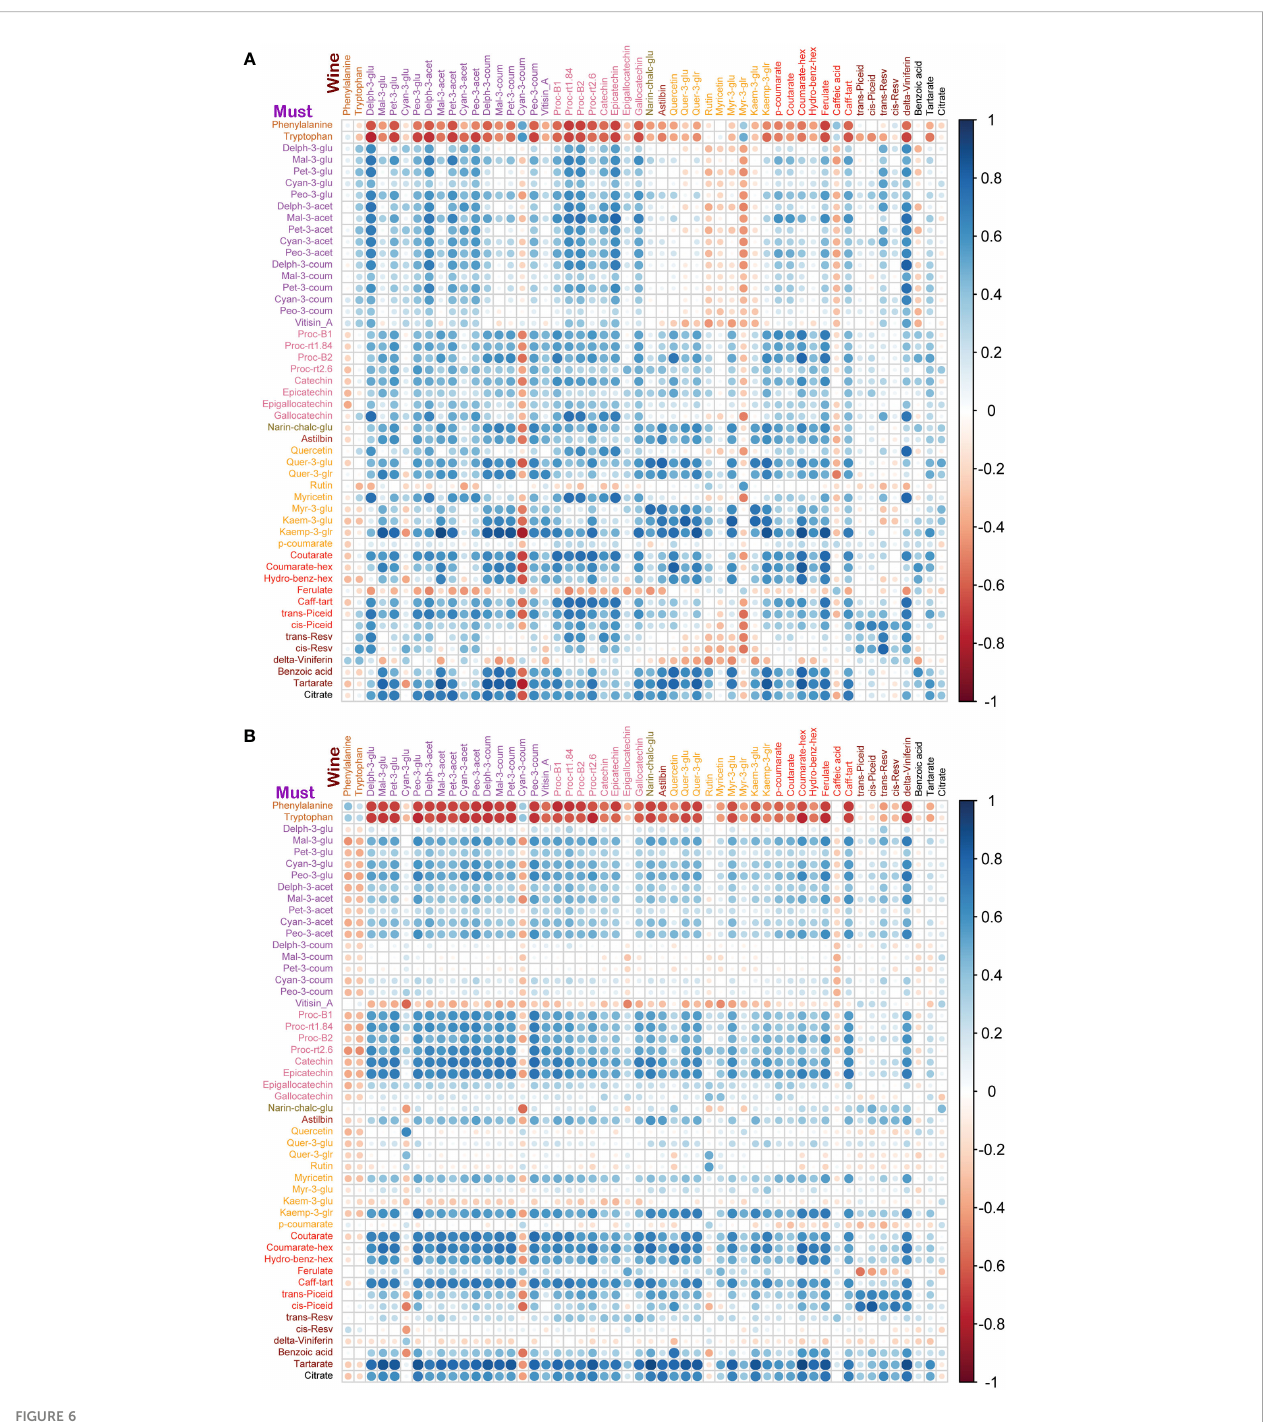
FIGURE 6 Correlation analyses between metabolites of must and wine samples from two cultivars. (A) In Syrah must and wine samples, must amino acids were negatively correlated with wine metabolites except for phenylalanine, cyan-3-coum, myr-3-glr and caffeic acid which were negatively correlated with most of the must metabolites. Must delta-viniferin was negatively correlated with most of the wine metabolites. (B) In Malbec must and wine samples, must amino acids were negatively correlated with wine metabolites except for amino acids and cyan-3-coum which were negatively correlated with most of the must metabolites. Must vitisin_A, kaem-3-glu and delta-viniferin were negatively correlated with most of the wine